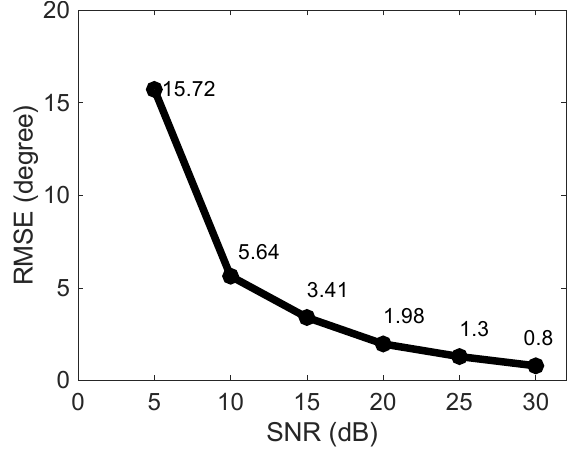
Figure 9. RMSE of the accuracy over the SNR run in a nRF52840 SoC.